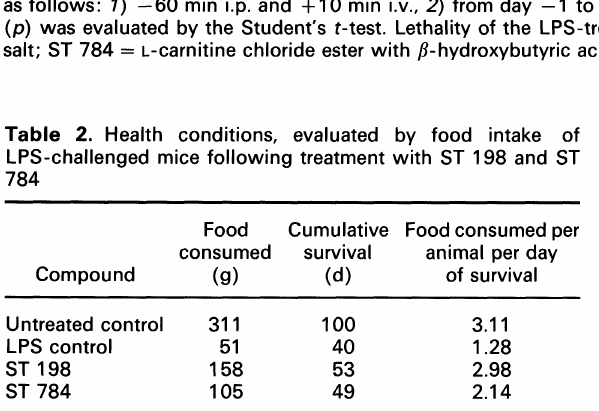
Table 1. Effects of L-carnitine (ST 198) and its derivative (ST 784) on both serum TNF and IL-6 production, and lethality of mice challenged with LPS TNF IL-6 Lethality % No. % No. Compound Treatment variation of mice p variation of mice p Dead/total ST 198 (50 mg/kg) -57 8 <0.05 + 124 8 <0.05 14/24 (16/24) (50 mg/kg) -64 <0.05